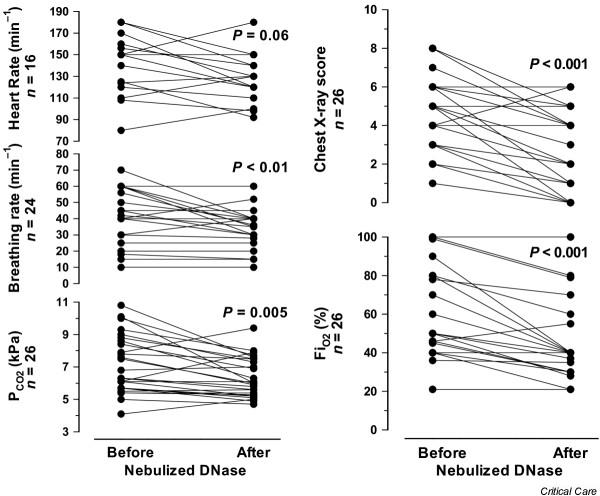
Change of cardiorespiratory parameters before and after treatment. Individual changes of the heart rate, breathing frequency, blood pCO2 and FiO2 before and within 2 hours, and the chest X-ray score before and within 24 hours after administration of DNase in 30 children treated for atelectasis. Although changes were statistically significant, a significant overlap was present before and after recombinant human DNase treatment (see also Table 1).